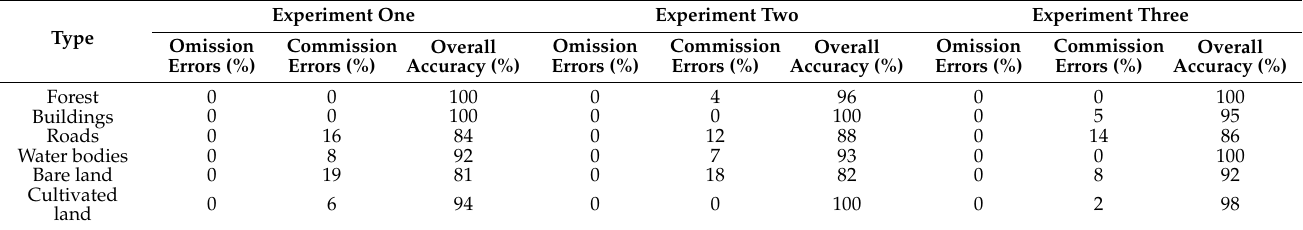
Table 4. The accuracies of outlier sample detection for six types of surface objects in the three experiments.